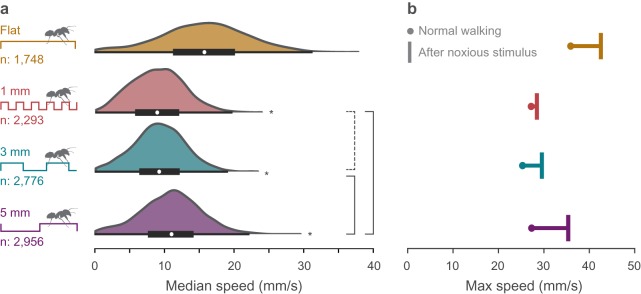
3D-printed uneven substrates constrain average and peak walking speeds in ants. (a) Preferred walking speeds decreased on uneven substrates. Speed distributions on all uneven substrates significantly differed from flat ground (asterisks, p < 0.0001, see S1 for statistical analysis) and from each other (solid brackets, p < 0.0001) except for 1 and 3 mm substrates (dashed bracket, not significant). (b) Maximum walking speeds were compared for unperturbed trials (dot) and those following a noxious airburst (T). Peak speed increased the least on the 1 mm substrate and most on the flat and 5 mm substrates.